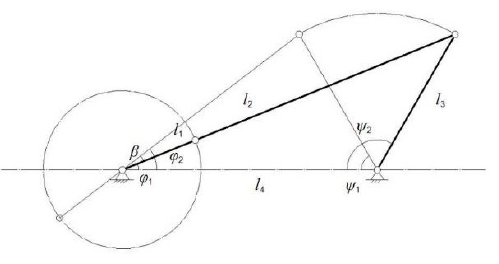
Figure 6. Position of the maximum swing angle of the rocker.